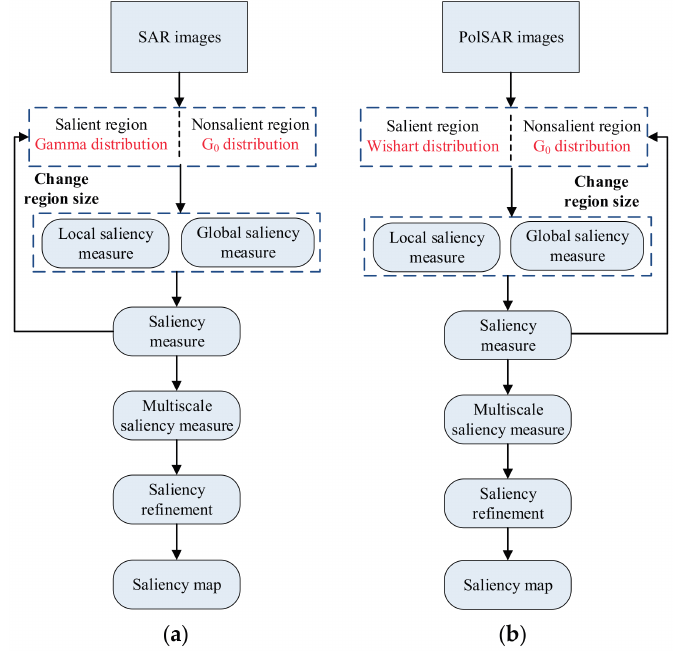
Figure 2. Framework of the proposed saliency map generation procedure. ( a ) Synthetic aperture radar (SAR) image saliency map generation; ( b ) Polarimetric SAR (PolSAR) image saliency